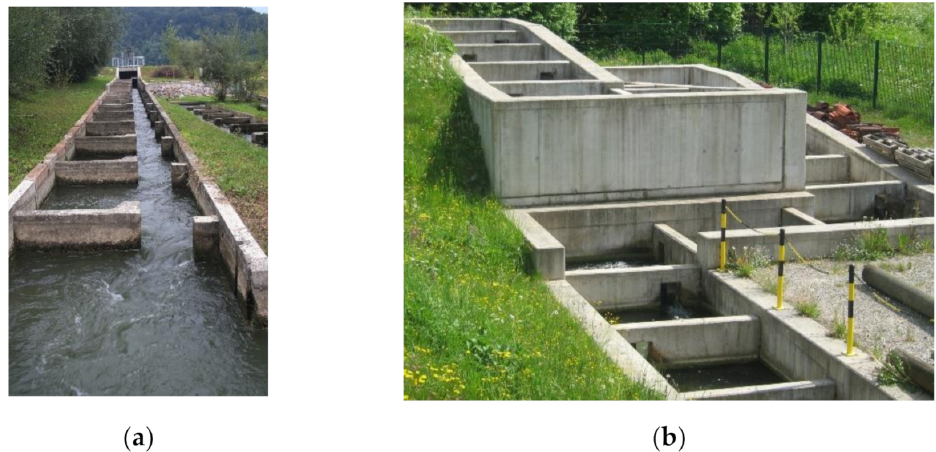
Figure 1. Examples of built technical fishways in Europe: ( a ) at HPP Rosegg and ( b ) at HPP Weissach (photo by E.